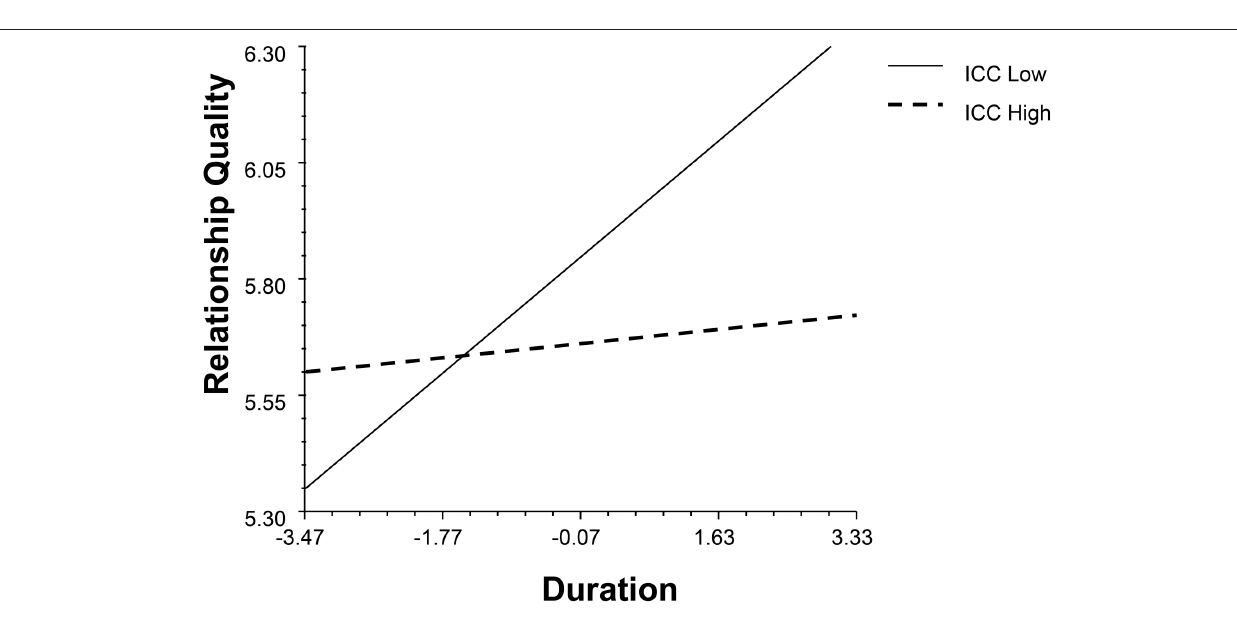
FIGURE 8 | The interaction between ICC and duration